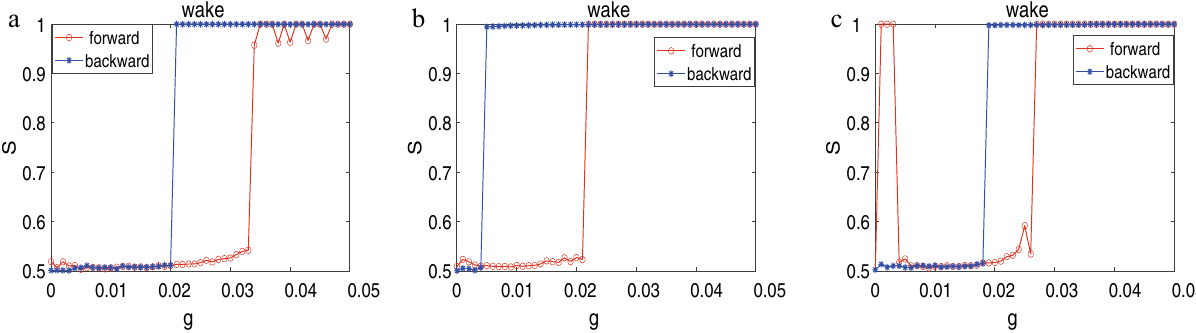
Figure 8. Transition to phase synchronization in forward and backward evolution of the networks. ( a ) The lattice network. ( b ) The ring-shaped regular network where each node randomly add 1 long-range connection. ( c ) The WS network ( k = 4, p = 0.1